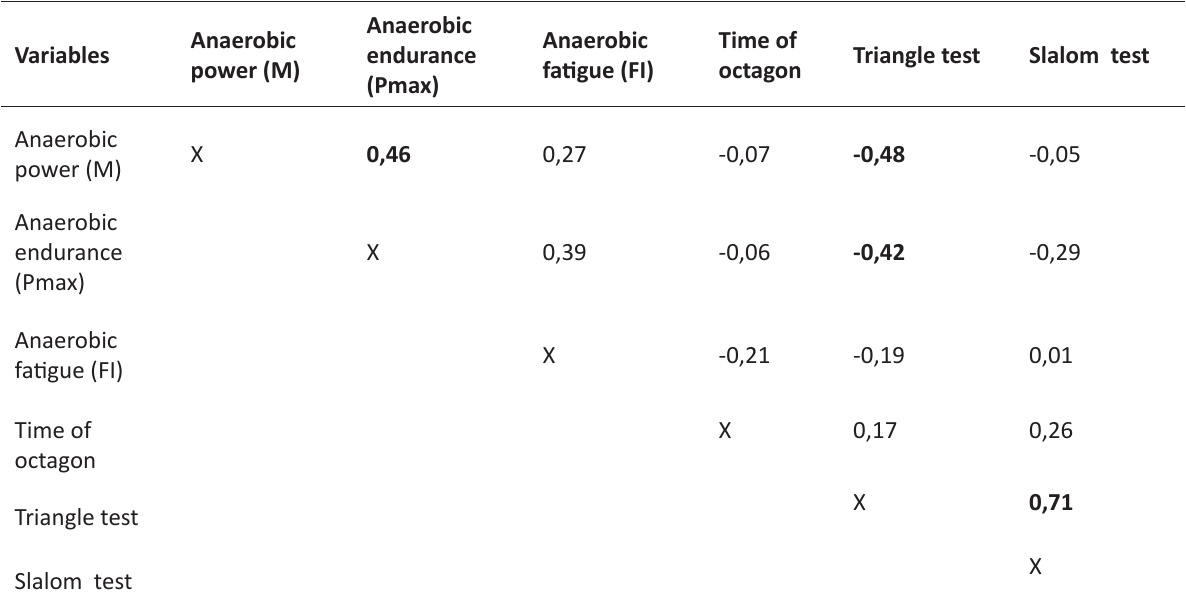
Table 5. The aggregated correlation results between the dry and snow performance of advanced skiers and beginners skiers respectively (p ≤ 0,05 n =